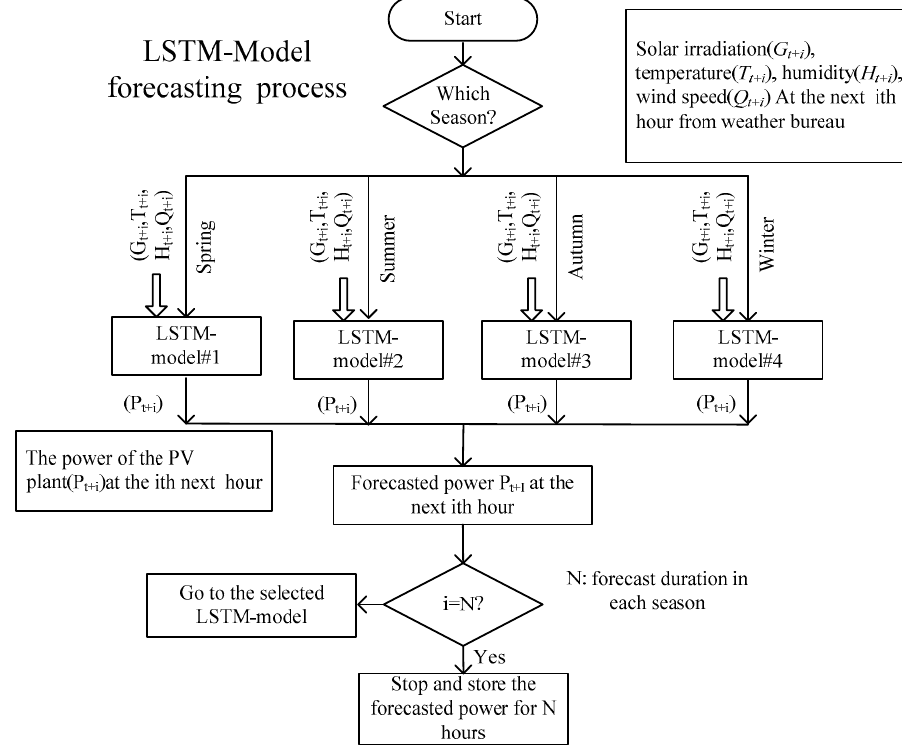
Figure 4. Flowchart of PV power forecasting design.